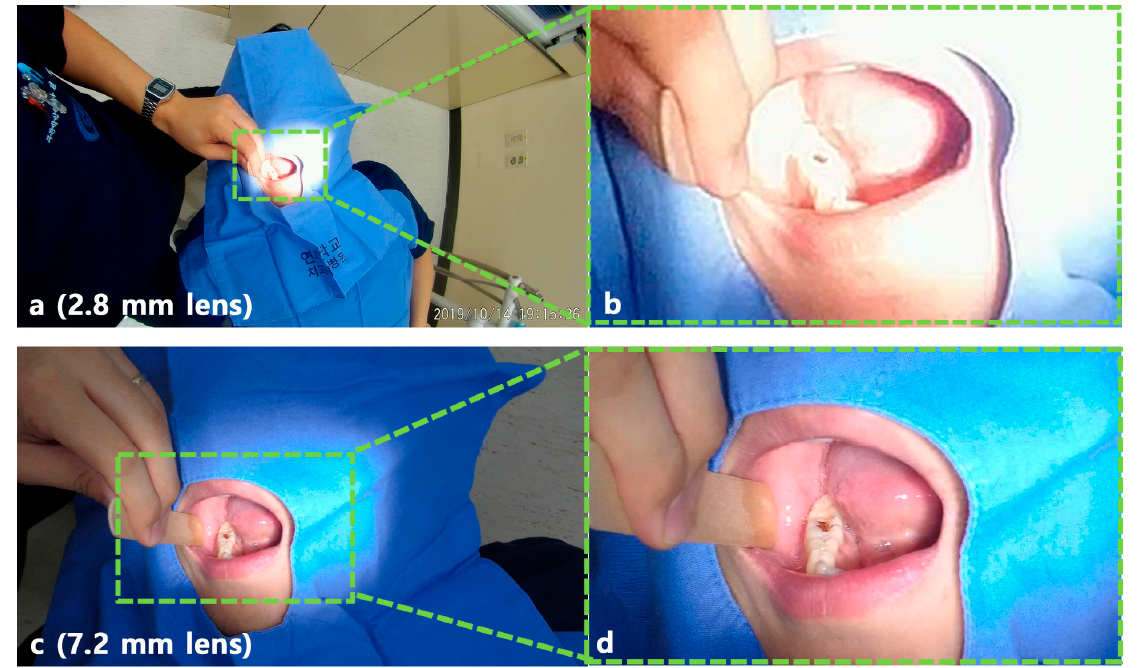
Figure 1. Snapshot of recorded video. ( a ) Image of action camera with original lens, ( b ) magnified photo of ( a ), ( c ) image with customized action camera, ( d ) magnified photo of ( c ).